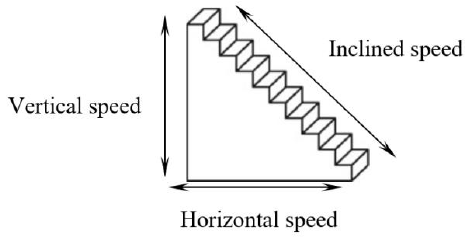
Figure 5. Definition of the ascending speed.